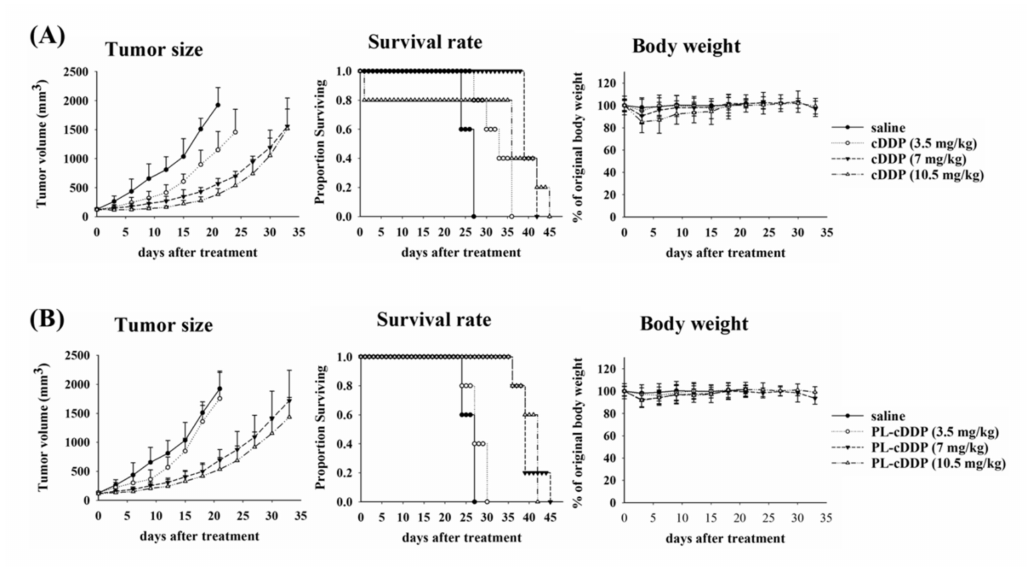
Figure 1. Therapeutic e ffi cacy of free form ( A ) and liposomal ( B ) cisplatin (cDDP) on nude mice bearing human S462-TY malignant peripheral nerve sheath tumor (MPNST) tumor. The xenograft mice were subjected to variable doses of cDDP (3.5, 7 and 10.5 mg / kg) via intravenous injection. Left panel, tumor size; Middle panel, survival rate; Right panel, body weight. Data are presented as mean ± S.D. for each group. Four mice were used in the group received 10.5 mg / kg; while five mice were used in other